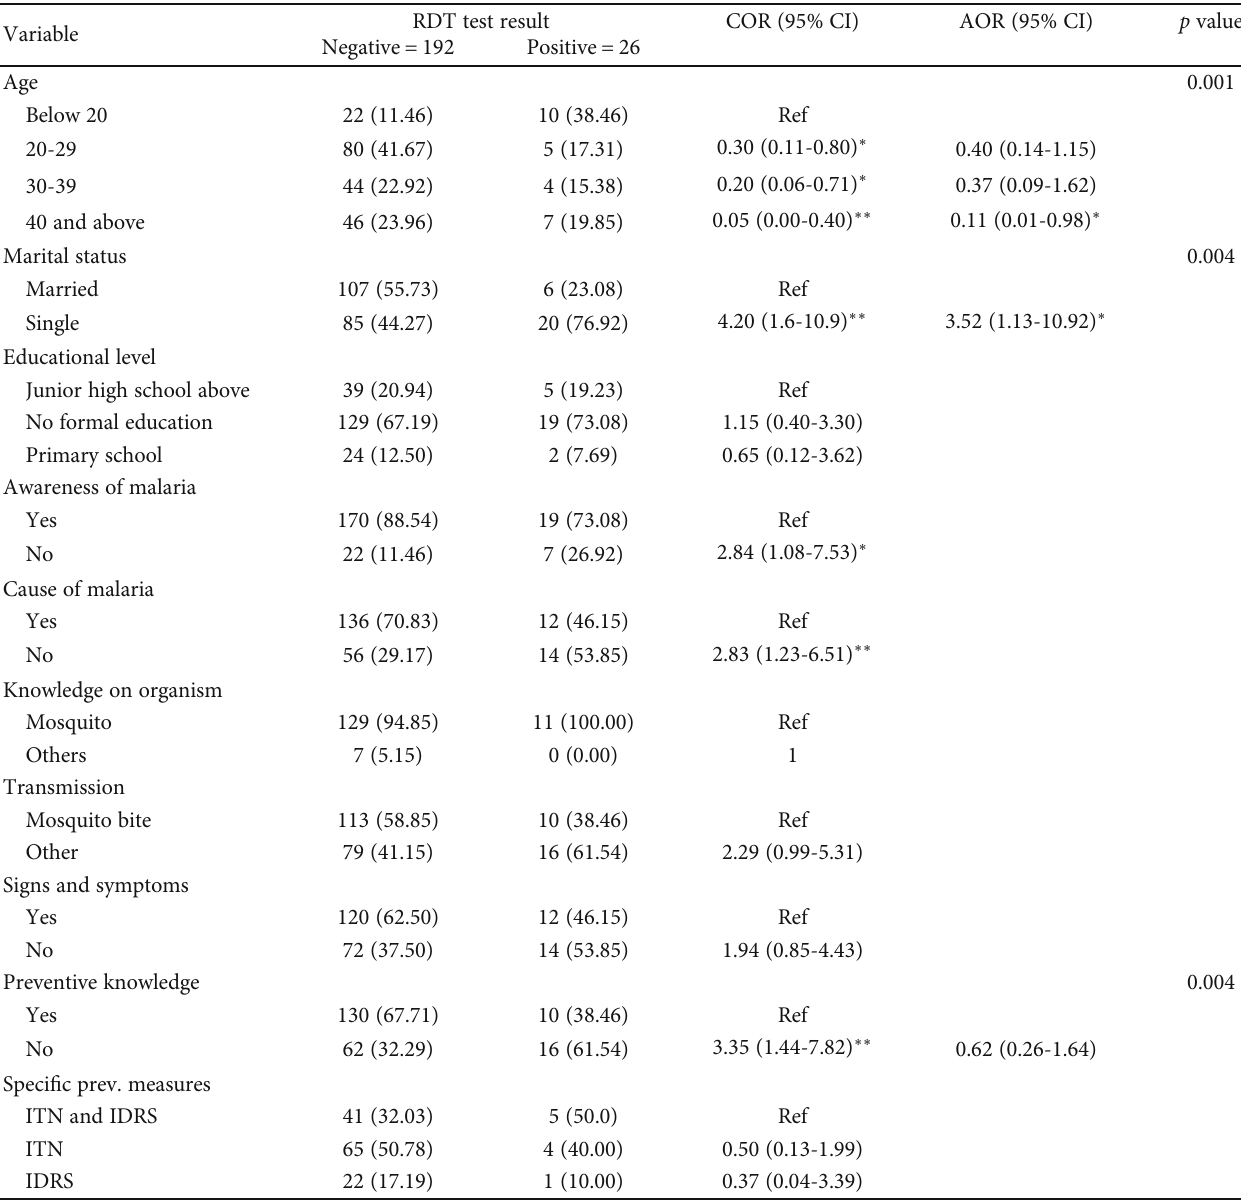
Table 4: Factors associated with malaria among head porters using logistic regression